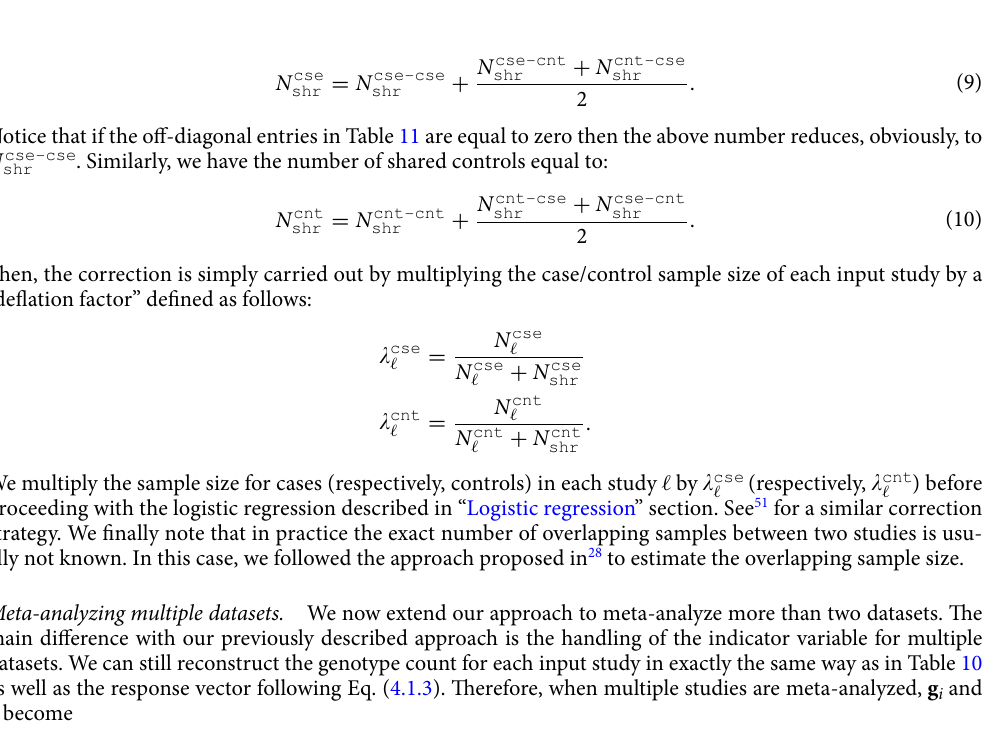
Table 11. Number of overlapping cases and controls between the two studies. For example, the first cell of the table indicates the number of shared cases between the two studies. In practice, the off-diagonal cells of this table are close to zero, since they indicate cases in one study that became controls in the other study and vice- versa. Large numbers in these off-diagonal cells would indicate high heterogeneity across the two studies, in which case a fixed effect meta-analysis is not